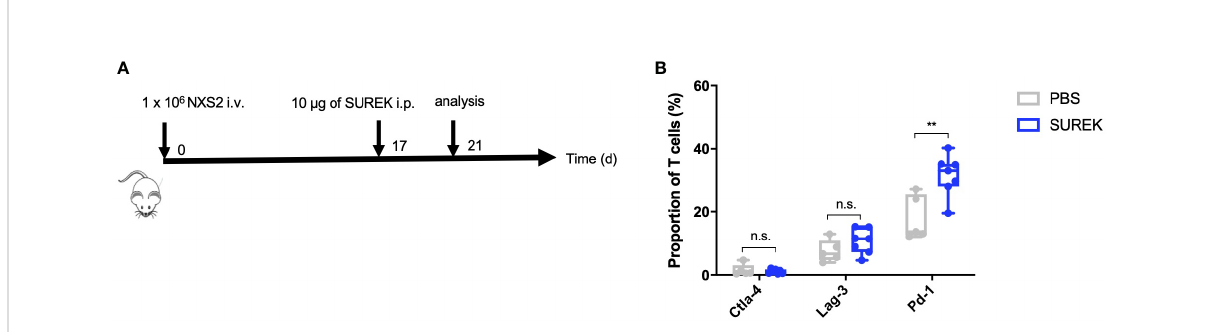
FIGURE 3 SUREK treatment leads to upregulation of Pd-1 on T cells. (A) A/J mice were injected with 1 x 106 NXS2 cells into a lateral tail vein (i.v.) and received one intraperitoneal (i.p.) injection with 10 µg of SUREK (GD2/Cd3) (n=7) or PBS (n=5) 17 days later. Four days after tumor injection, mice were sacri fi ced for analysis of tumor in fi ltrating T cells (TILs). (B) Expression of indicated checkpoint molecules on TILs of mice treated as described in (A) . Cd3 was used as a marker for T cells. Results are pooled from two independent experiments. Student´s t test: **p<0.01; n.s., not signi fi